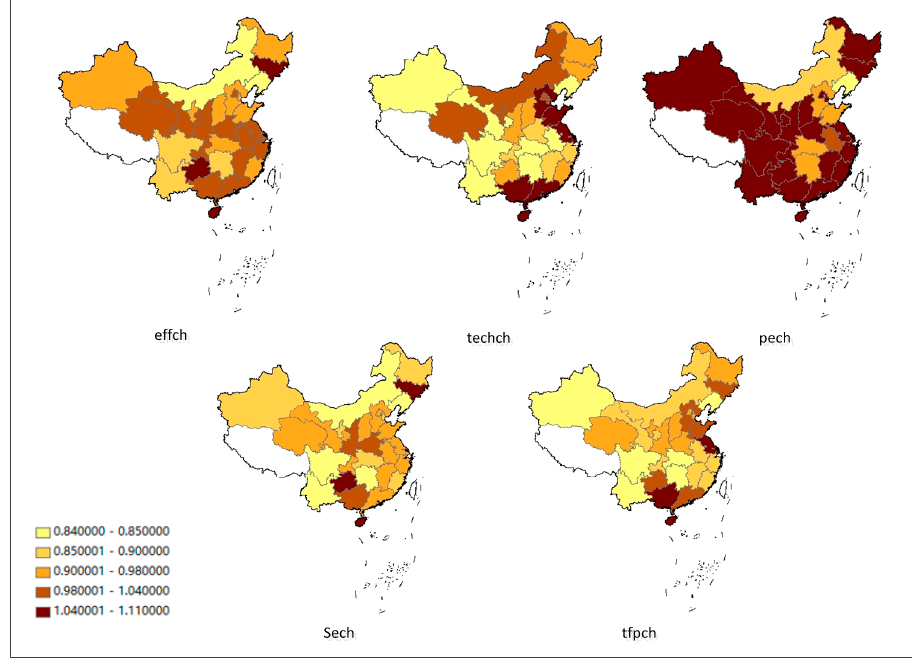
Figure 7. Malmquist Index and Its Decomposition of Green Buildings’ Management Efficiency in Each Region. Each